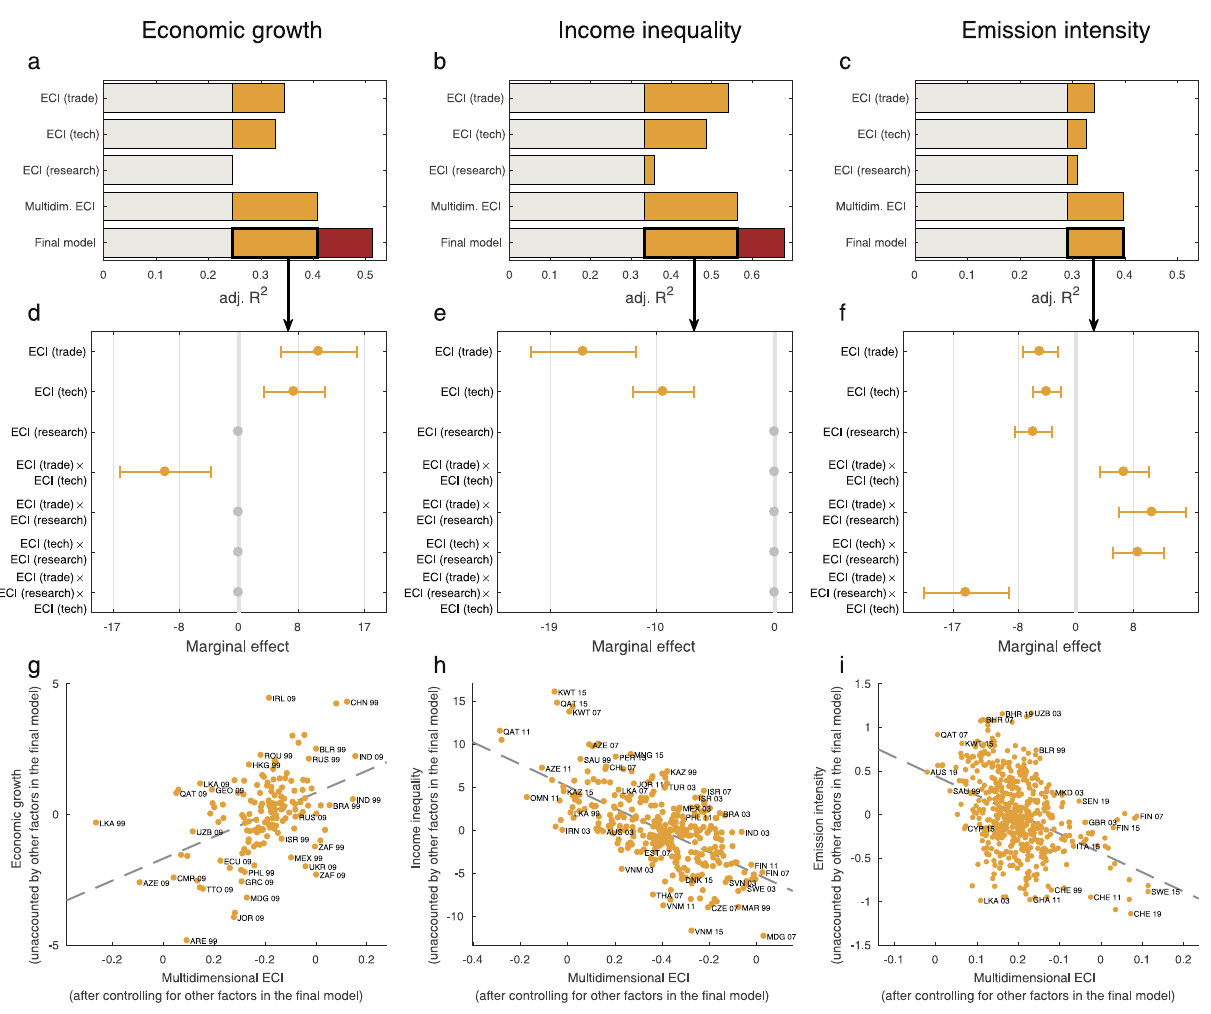
Fig. 3 Explaining international variations in economic growth, income inequality, and emission intensity with multidimensional economic complexity. a – c Contribution of the baseline, ECIs, and other covariates to the variance explained by various models (adjusted R 2 ) for a economic growth, b income inequality, and c emission intensity. The baseline adjusted R 2 s are presented in gray, the contributions of the three individual ECIs and of the multidimensional ECI in orange, and the variance explained by additional factors in the fi nal model is shown in red. d – f Error bars for the marginal effects (with 95% con fi dence intervals) for the ECI coef fi cients in the fi nal models for d economic growth (Supplementary Table 4, column 17), e income inequality (Supplementary Table 12, column 17), and f emission intensity (Supplementary Table 21, column 14). g – i The conditional correlation between the multidimensional ECI (created by weighting each ECI coef fi cient according to the size of the regression coef fi cient in the fi nal model) and g economic growth, h income inequality, and i emission intensity. Conditional correlations are obtained by controlling for all other factors included in the fi